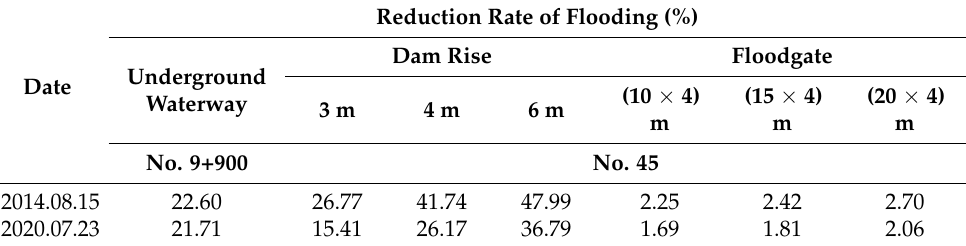
Table 2. Flood reduction rate in the Suyeong River and the Oncheon River (actual